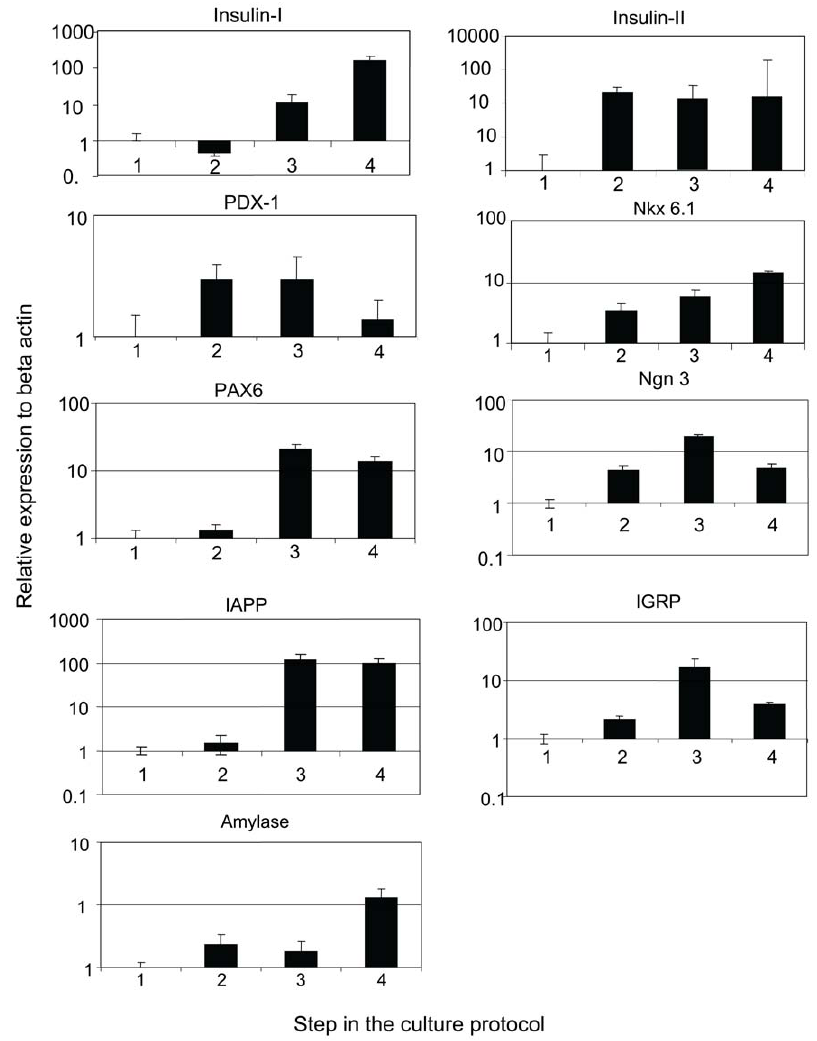
Figure 3. Quantitative PCR results of pancreatic markers (insulin-I, insulin-II, IAPP, IGRP, amylase, PDX-1, Nkx 6.1) and endocrine markers (PAX6 and Ngn 3) in the cells cultured by the protocol. The expression of each gene is illustrated as expression of SYBR green (semi- log scale in the Y-axis) relative to its levels in ES cells (1).